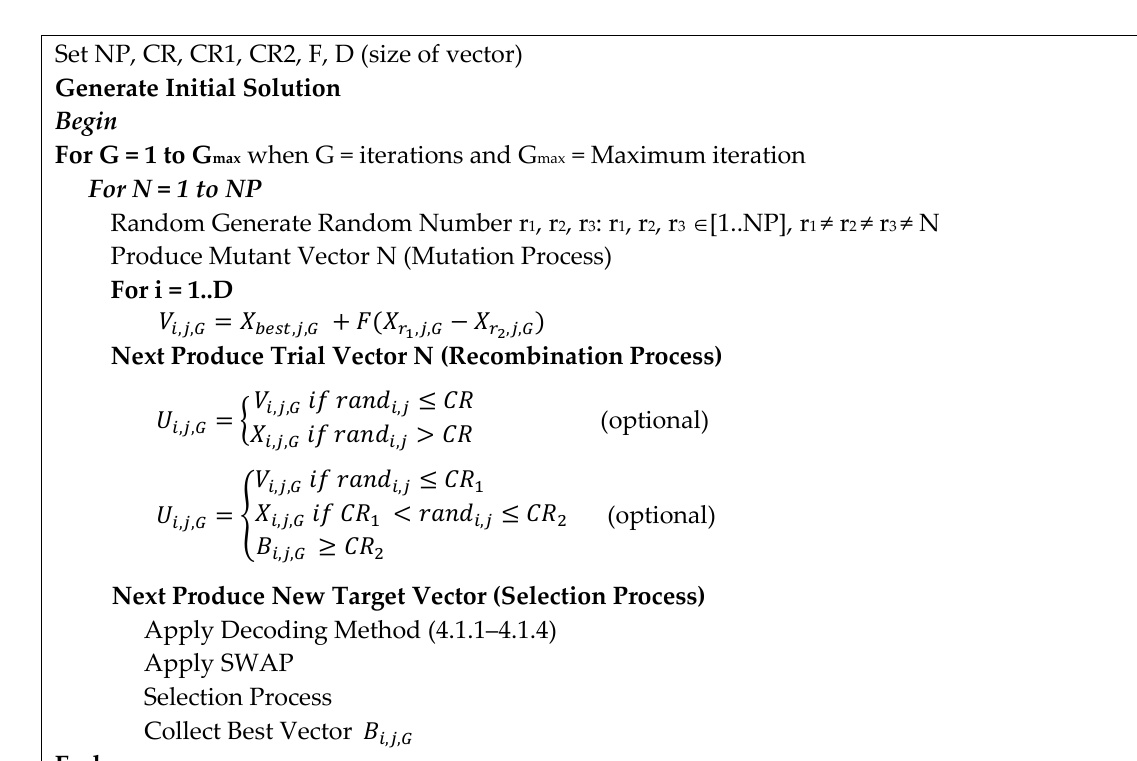
Figure 4. The pseudo code of the modified DE.